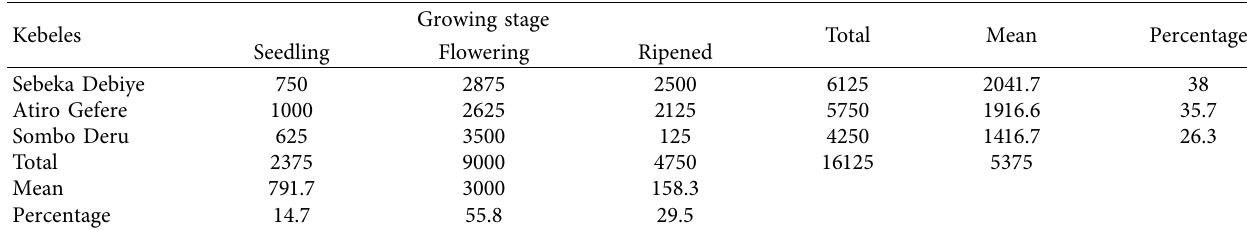
Table 3: Te number of plants damaged and percentage damaged by grivet monkey feeding on maize crops at each stage of development per hectare.